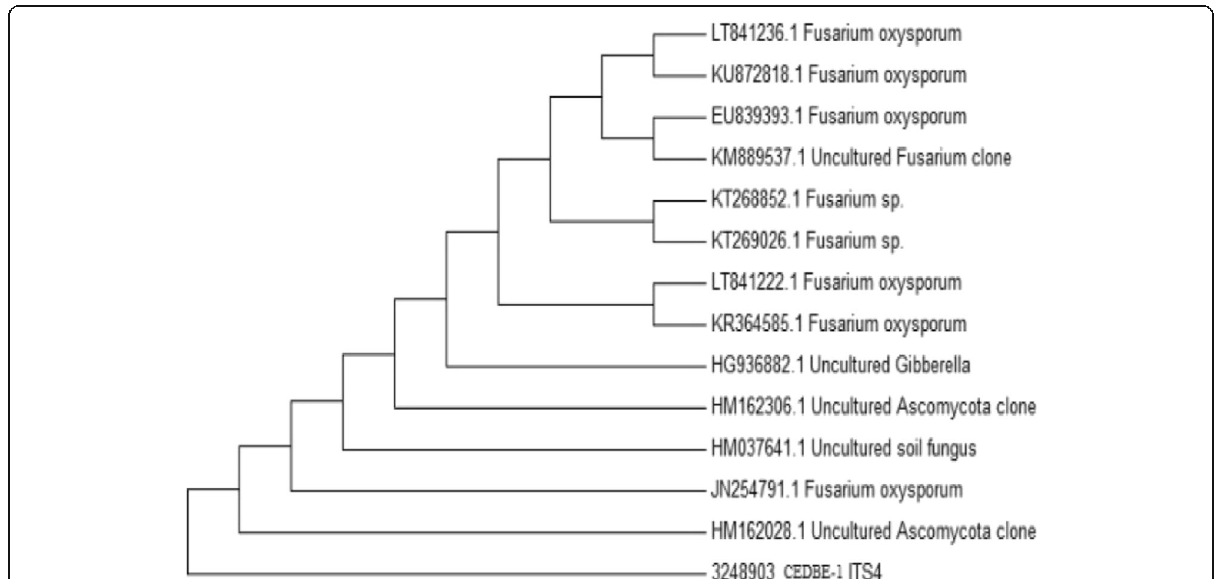
Fig. 4 Phylogenetic relationship for 5.8S-rRNA-ITS regions between the endophytic fungus CEDBE-1 and published data. Phylogenetic tree